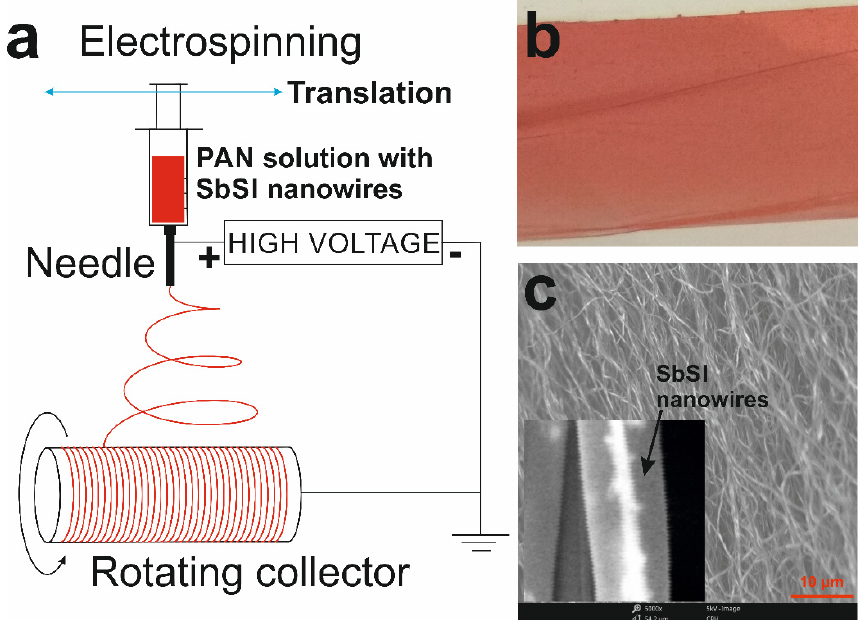
Figure 3. ( a ) Scheme depicting the electrospinning set-up for fabrication of PAN/SbSI fibrous mats. ( b ) An exemplary photograph and ( c ) a SEM image of PAN/SbSI composite mat. The inset of ( c ) shows a single nanofiber with of SbSI nanowires.